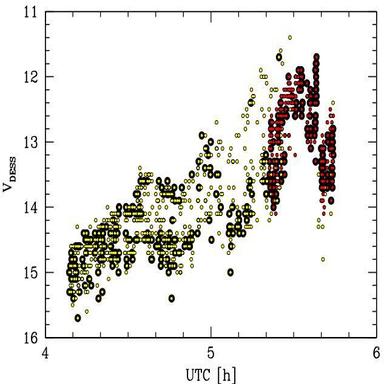
The full DeSS data set of 1125 V-band observations along the WT1190F final approach of 2015 November 12–13. The magnitude sample of the TRACKER (yellow markers) and ANTSY (red markers) telescopes (708 and 417 points, respectively) are merged in the plot, without relative offset correction. Bold points (for the two telescopes) refer to the astrometric DASO measurements). The x-axis timeline is in UTC hours of November 13. (For interpretation of the references to color in this figure legend, the